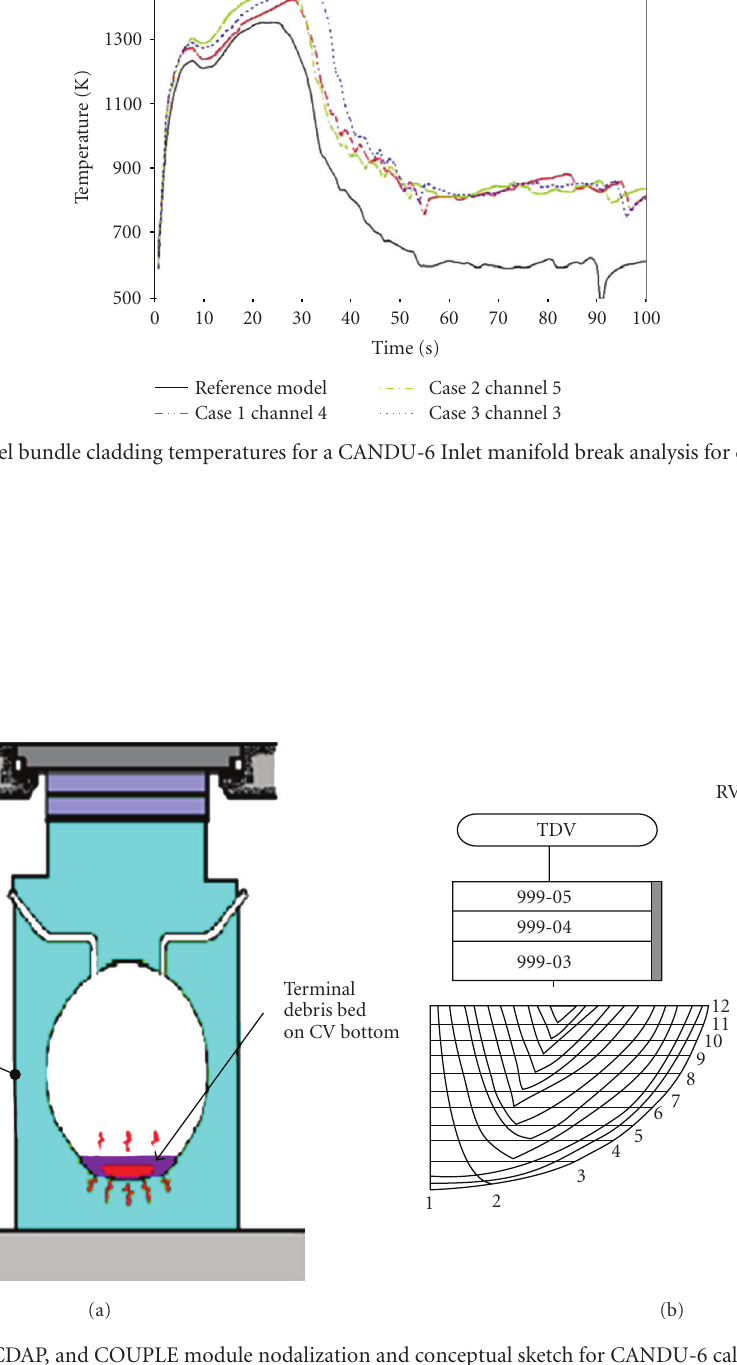
a noticeable impact on the results for the inlet header manifold [14], the fuel channels (simulating the e ff ects of horizontally stratified flow in the channels) [13], and the outer pool (exterior to the vessel calandria)